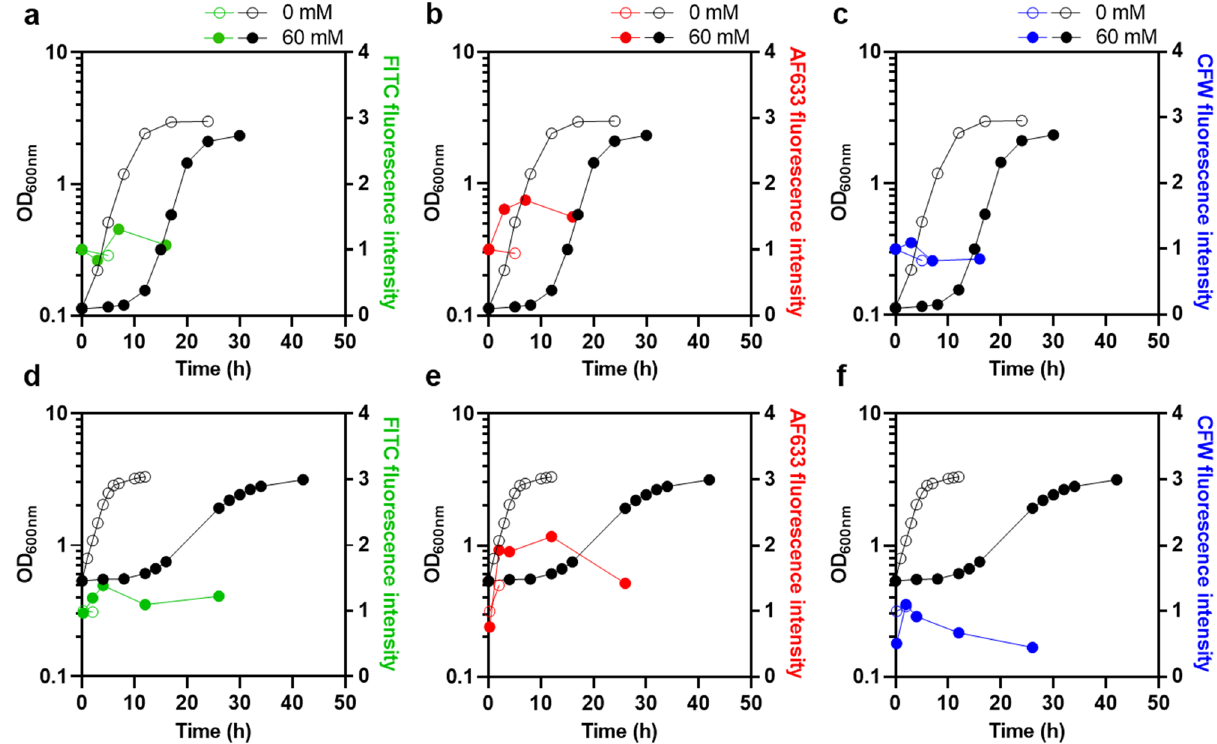
Figure 4. Content of cell wall polysaccharides in yeast cells during adaptation to acetic acid stress by fluorescence microscopy. Quantitative analysis of the cell wall polysaccharides during cultivation of S. cerevisiae BY4741 in the absence (open circle) or presence (filled circle) of acetic acid, as described for Figs. 1, 2, 3 ( a – c ). Results of an independent experiment using a higher level of acetic acid stress and a higher initial biomass concentration (corresponding to initial OD 600nm of 0.5 ± 0.05) are also shown ( d – f ). The cell wall components mannans (green), β-glucans (red) and chitin (blue) were stained with Concanavalin A conjugated with Fluorescein (FITC), Fc-Dectin 1 conjugated with Alexa Fluor 633 (AF633) and Calcofluor White (CFW), respectively. Quantification of the fluorescence intensity was performed with a Leica TCS SP5 (Leica Microsystems CMS GmbH, Manheim, Germany) inverted confocal microscope (DMI600). Median fluorescence intensity values result from the analysis of, at least, 34 cells obtained from two replicates. Individual cell measurements can be consulted in Supplementary Figure